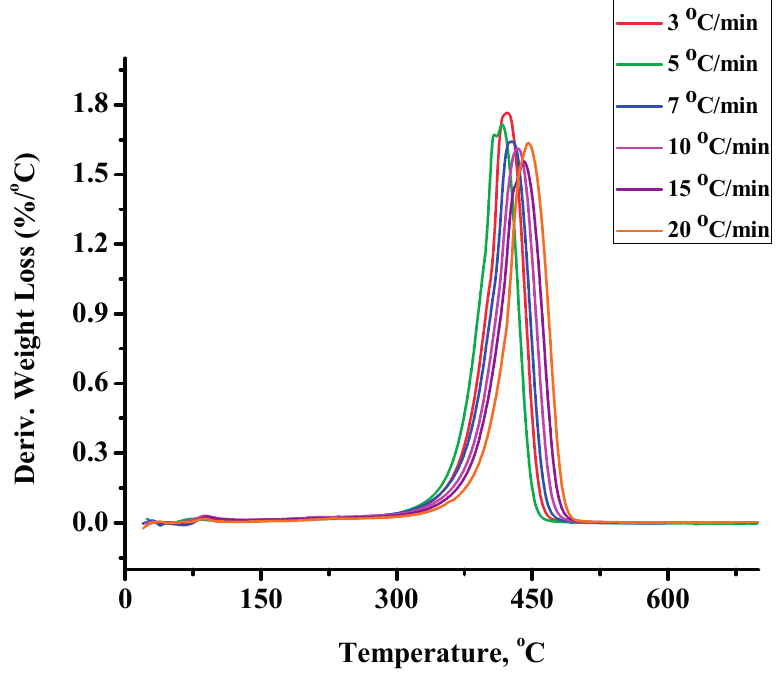
Figure 5. Derivative weight loss with temperature for the sample 20/80P under different heating